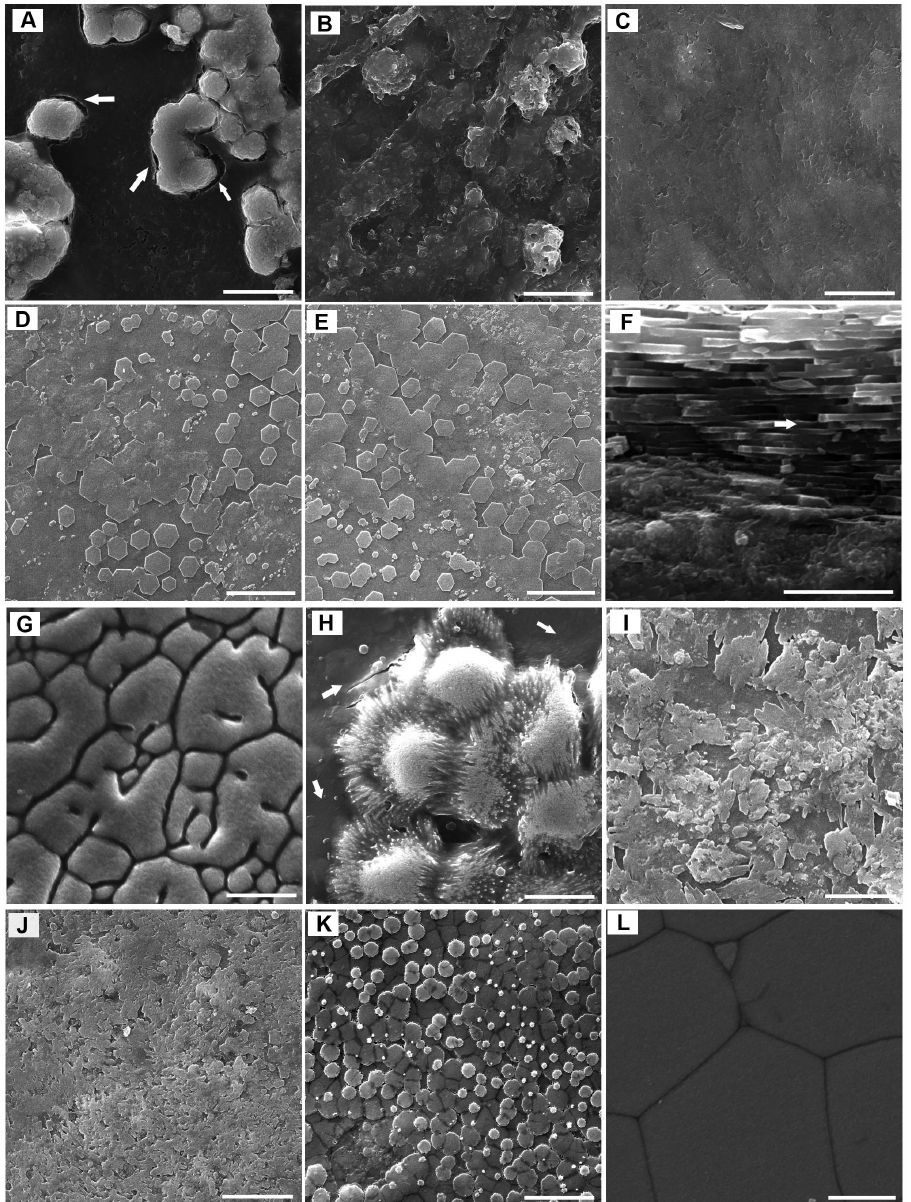
Figure 1. Scanning electron microscope images of the deposition on the surface. (A) 5d (the inner-shell film indicated by arrows), (B) 10d, (C) 15d, (D) 20d, (E) 25d and (F) cross section of 25d (brick and mortar structure indicated by arrows) in the inner-shell film system. Growth direction is towards the top in (F). (G) 5d, (H) 10d (the new forming organic film indicated by arrows), (I) 15d, (J) 20d and (K) 25d in the film-free system. (L) prismatic layer of adult shell. Scale bars, 10 m m in (A), (B), (C), (D), (E), (G), (H), (I), (J), (K) and (L), 4 m m in